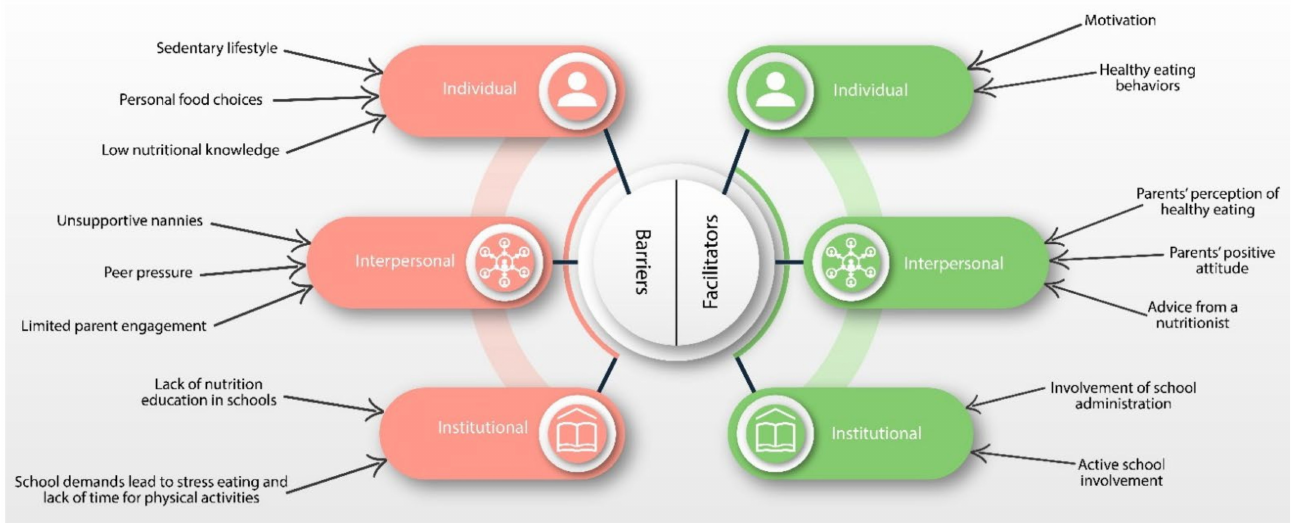
Figure 1. Barriers and Facilitators of health body weight among 9–13 old school